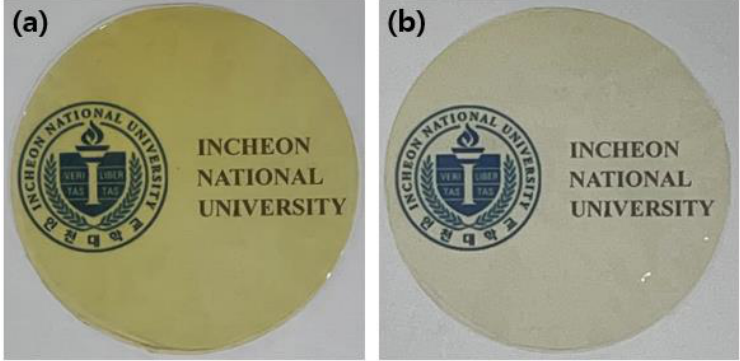
Figure 2. Photographs of ( a ) x-TriPPO-50SEBS A and ( b ) x-PPO-50SEBS B. The constructed crosslinked membranes had QA as their ion-conducting head group.